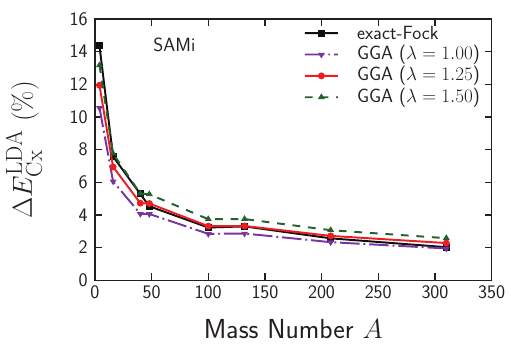
Figure 1. Deviation between the PBE-GGA and the LDA, ∆ E LDA defined as Eq. (3.4). For comparison the deviation be- Cx tween the exact-Fock and the LDA is also shown. Taken from Ref.